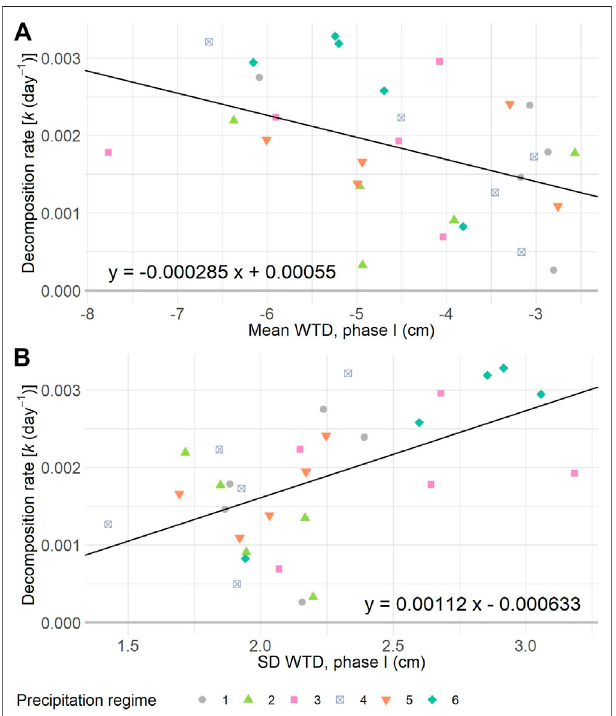
FIGURE 3 | Decomposition rate constant k of graminoid litter plotted against the mean WTD (A) and standard deviation (SD) of the WTD (B) per mesocosm, during one of six precipitation regimes. Shown regression lines are signi fi cant at p < 0.05. In A: R 2 adj (cid:2) 0.17, in B: R 2 adj (cid:2) 0.28. For details on precipitation regimes, please see Figure 1 .